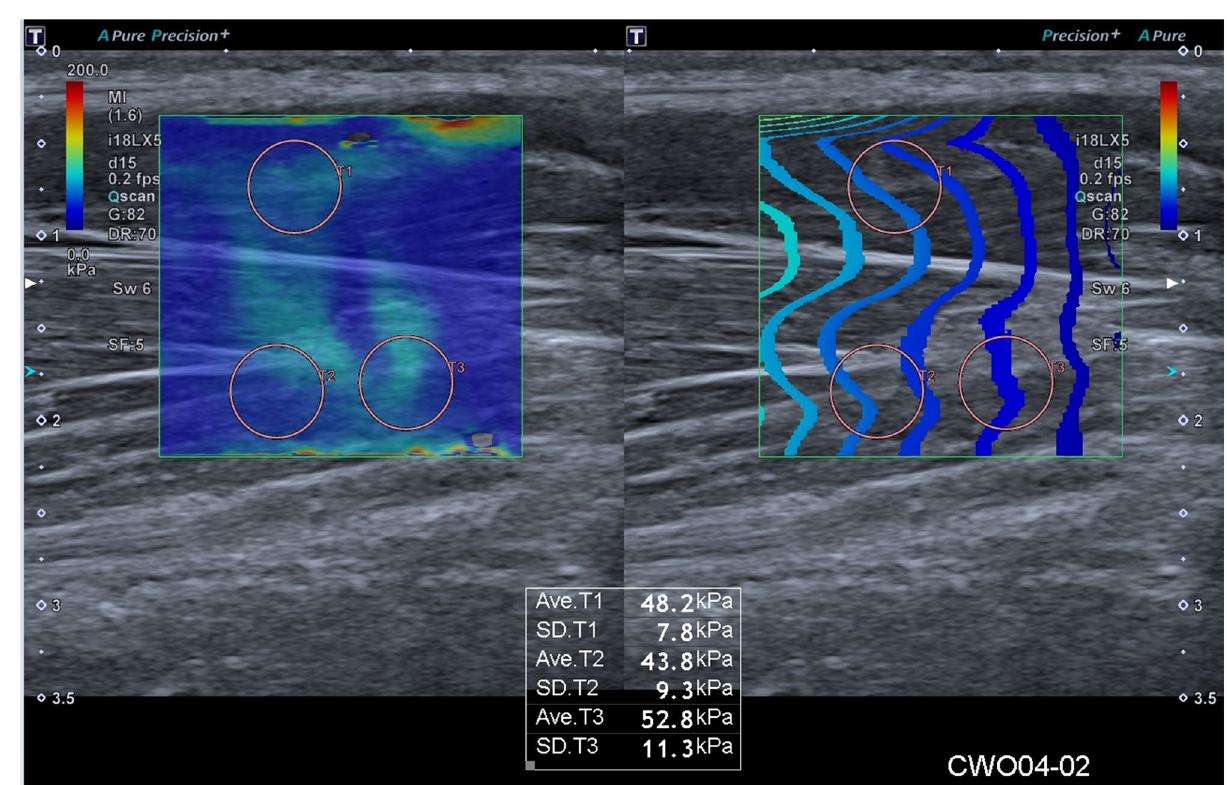
Figure 9. Shear wave elastography image in the region of interest with the calculated value from the ultrasound